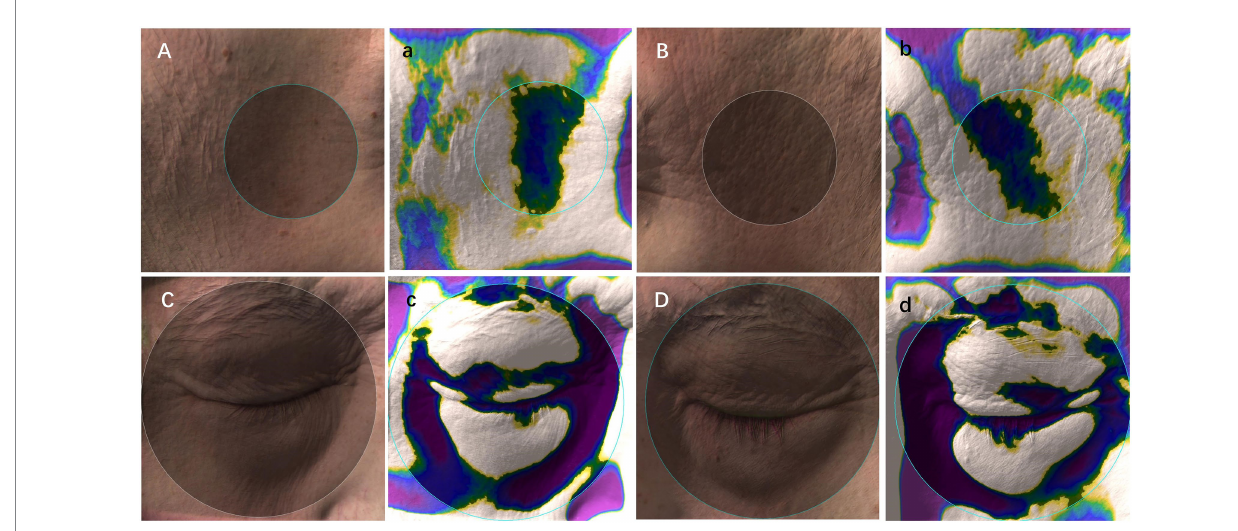
FIGURE 1 Schematic diagram of 3D image recognition and depression index acquisition. (A–D) : skin images; (a–d) : depression index sampling (gray region, the reference level; green, blue, and purple regions, depressions); Note: the circle indicated the pre-specified target area to obtain the quantitative data of depression volume, affected area, and maximum depth of temporal (diameter = 30.8 mm) and periorbital (diameter = 54.1 mm).